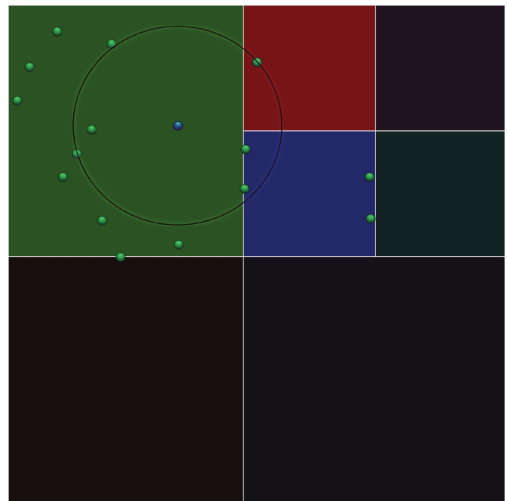
Figure 3: Sample spatial subdivision based on a quad-tree. Active regions are brightly colored.